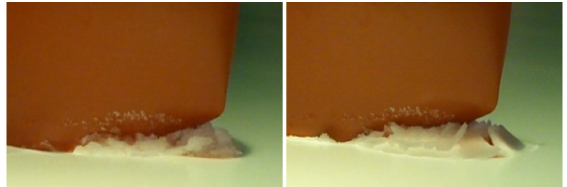
Figure 8: Screenshots from an icebreaking run in ice basin, running ahead in 22 mm (0 . 53 m full- scale) level